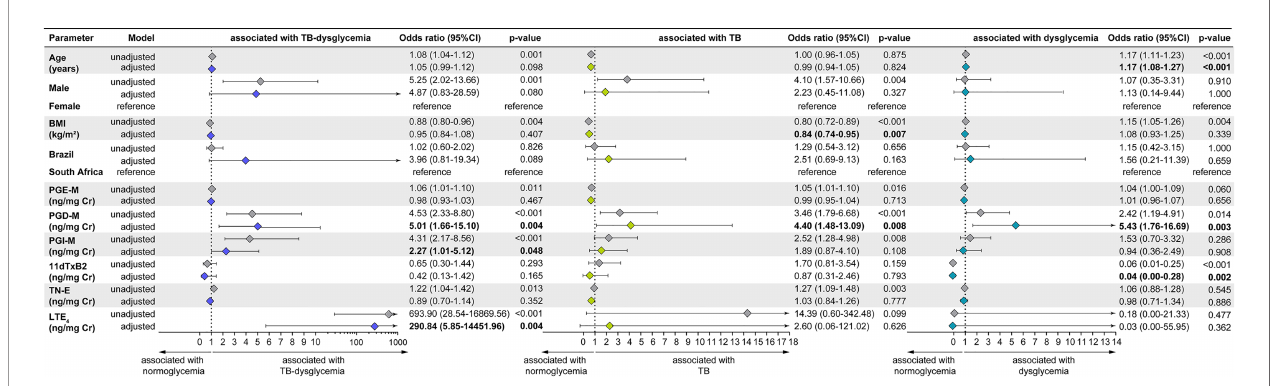
FIGURE 5 | Multinomial logistic regression, adjusted for age (years), sex (male), country, PGD, PGIM, TNE, 11dTxB2, LTE4 and BMI assessed at baseline with the TB-dysglycemia condition. OR, Odds ratio; 95% CI, 95% con fi dence intervals; PGE-M, major urinary PGE 2 metabolite; PGD-M, major urinary PGD 2 metabolite; PGI- M, 2,3-dinor-6-keto-PGF 1 a (PGI 2 Metabolite); 11dTxB2, 11-dehydro-thromboxane B 2 (TxB 2 urinary metabolite); TN-E, tetranor-PGE 1 (urinary PGE 2 metabolite); LTE 4 , Leukotriene E 4